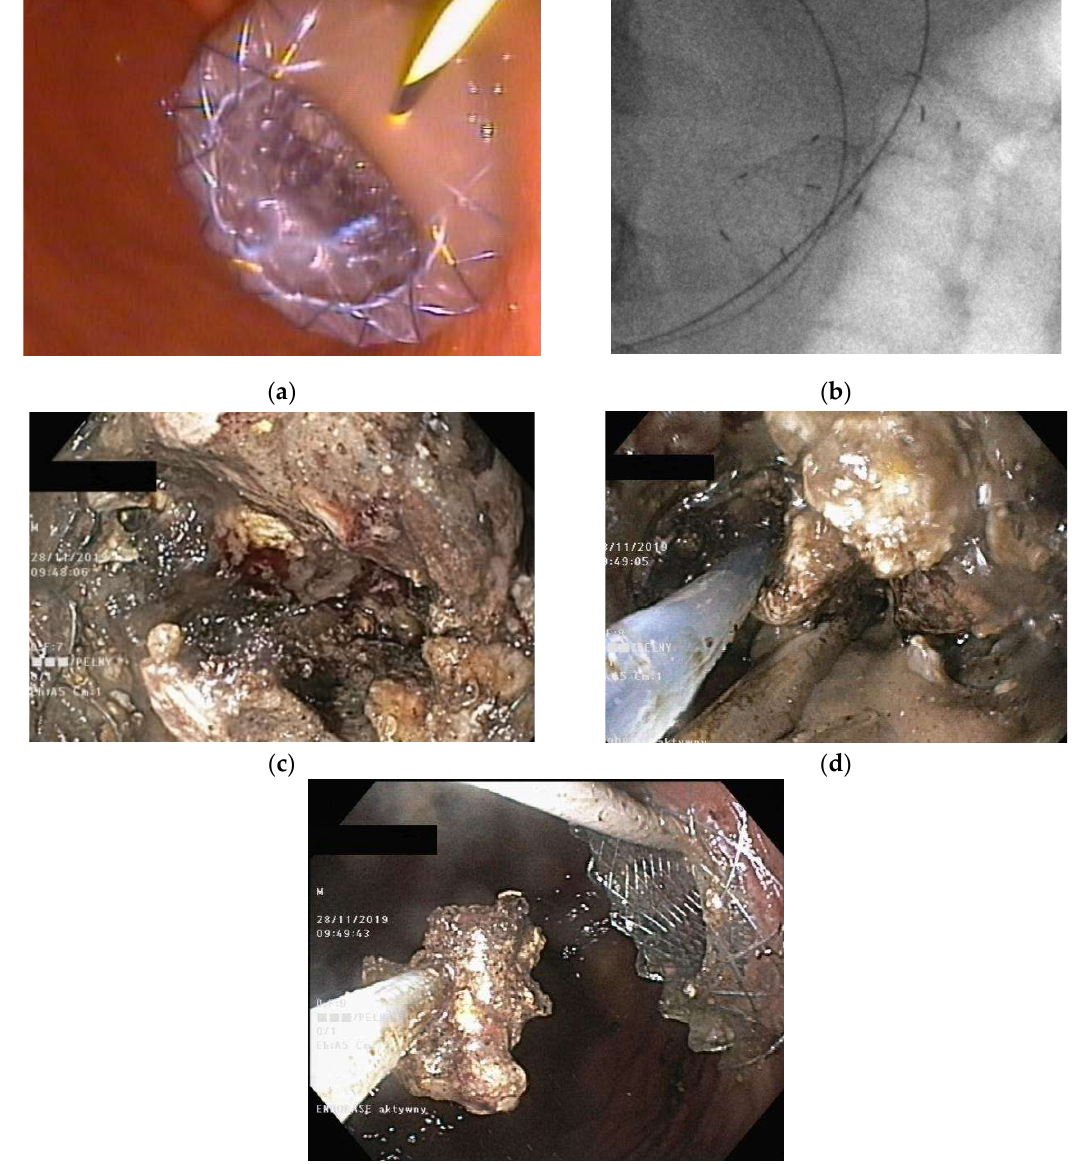
Figure 7. ( a – e ), Endoscopic treatment of WOPN with use of the Hot AXIOS lumen-apposing stents. During the first endoscopic procedure the cystogastrostomy was performed ( a – c ). The outflow of necrotic content through the transmural stent is visible. During the next endoscopic procedure, the endoscopic necrosectomy was performed. Through the lumen of stent, the gastroscope was inserted to the lumen of necrotic cavity and necrotic tissues were removed with the use of a Dormia basket.